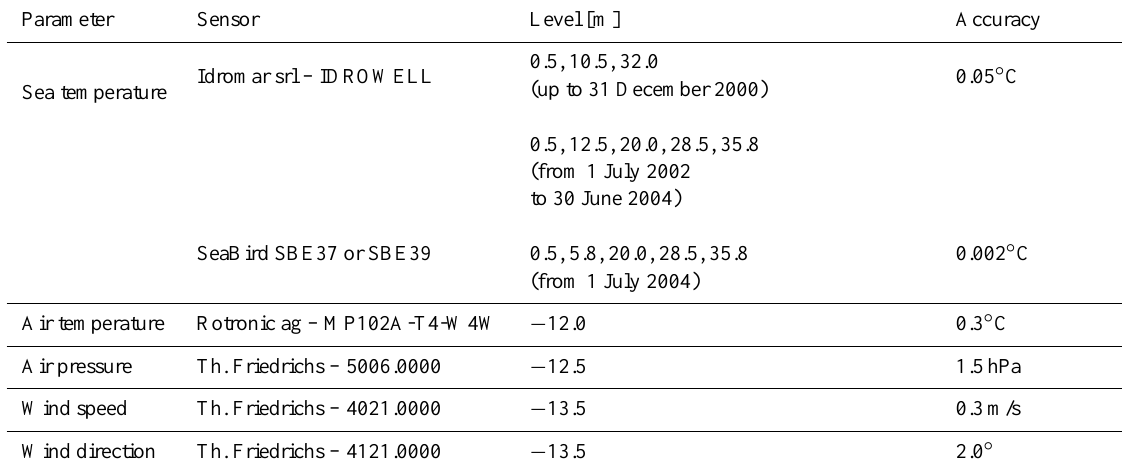
Table 1. Descriptions of the meteorological and marine sensors installed on the ODAS Italia 1 buoy which provided the data used in this paper; heights above sea level are reported as negative values.